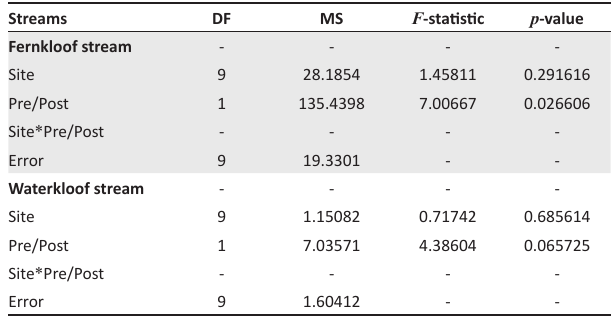
TABLE 2: A summary of pre-flood and post-flood longitudinal (upper and lower stream reaches) and disturbance (pre-flood and post-flood) main-effects ANOVA results for Pseudobarbus afer CPUE (fish m -3 ) from the Waterkloof and Fernkloof streams, headwater tributaries of the Kwa-Zunga River within the Groendal Wilderness